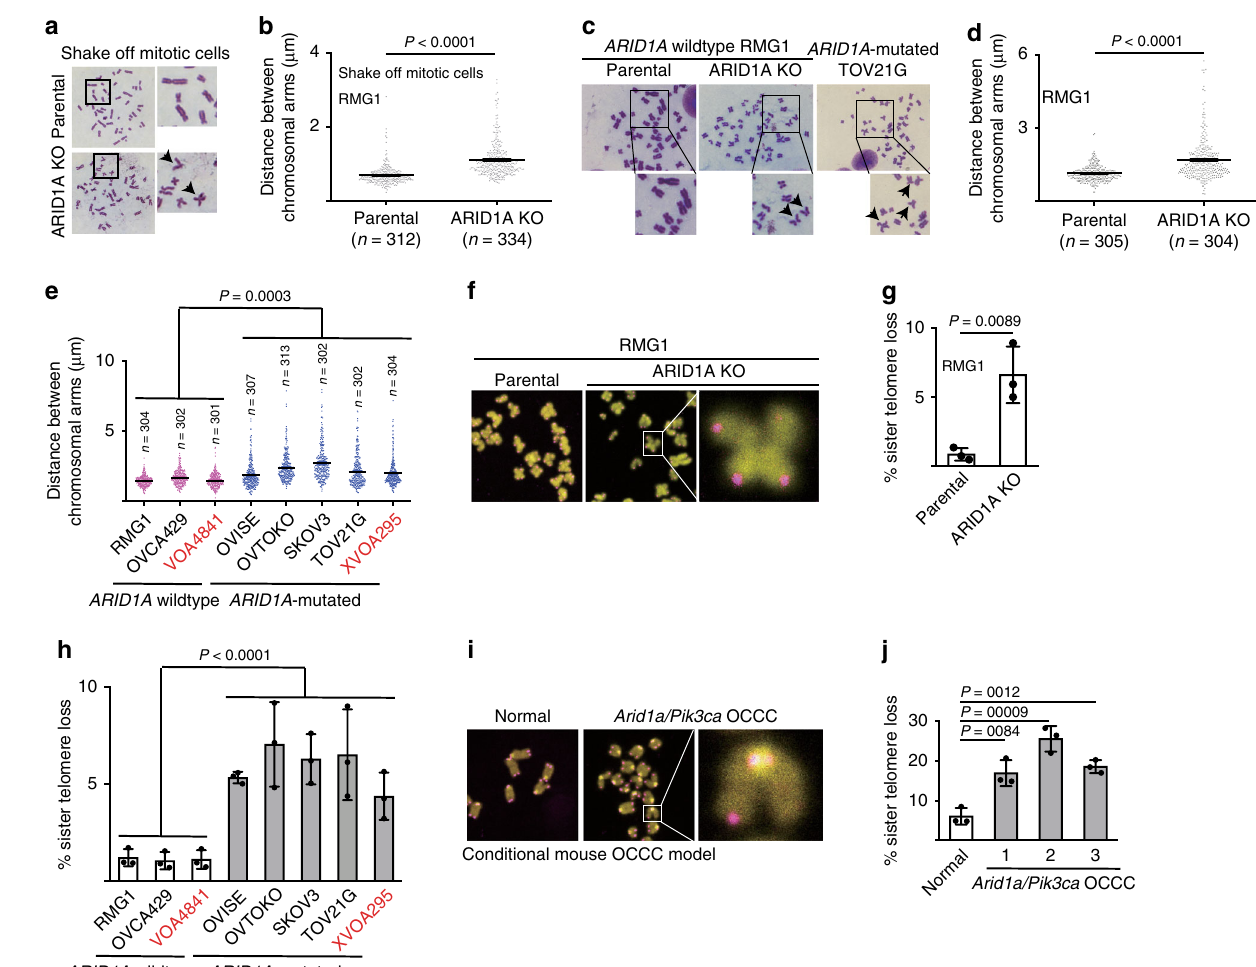
Fig. 1 ARID1A inactivation causes defective telomere cohesion. a , b Representative images of prometaphase chromosome spreads ( a ) and quanti fi cation of distance between distal ends of sister chromatids ( b ) enriched by mitotic shake-off from parental and ARID1A knockout RMG1 cells. c – e Representative images of chromosome spreads ( c ) and quanti fi cation of distance between distal ends of sister chromatids ( d ) enriched by colcemid treatment from parental and ARID1A knockout RMG1 cells, and ARID1A mutated TOV21G cells. And quanti fi cation of distance between distal ends of sister chromatids enriched by colcemid treatment from the indicated clear cell ovarian cancer cell lines or primary cultures highlighted in red ( e ). f , g Representative images of telomere fl uorescent in situ hybridization ( f ) and quanti fi cation of mitotic telomere signal loss ( g ) in parental and ARID1A knockout RMG1 cells. h Quanti fi cation of mitotic telomere signal loss in the indicated clear cell ovarian cancer cell lines. i , j Representative images of telomere fl uorescent in situ hybridization ( i ) and quanti fi cation of mitotic telomere signal loss ( j ) in cells isolated from normal mouse ovary and Arid1a − / − / Pik3ca H1047R genetic clear cell ovarian tumors respectively. n = 3 independent experiments unless otherwise stated. Data represent mean ± s.e.m. P values were calculated using a two-tailed t test except in 1e and 1 h by multilevel mixed-effects